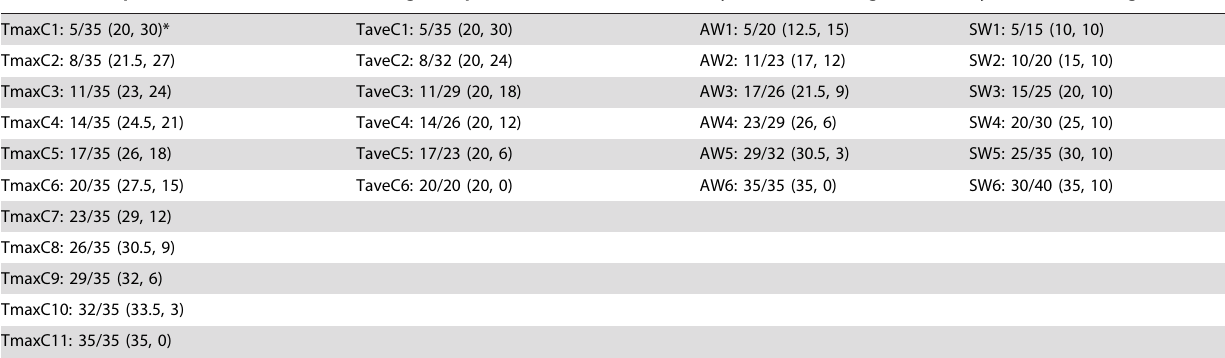
Table 1. The alternating temperature regimes used in the study.